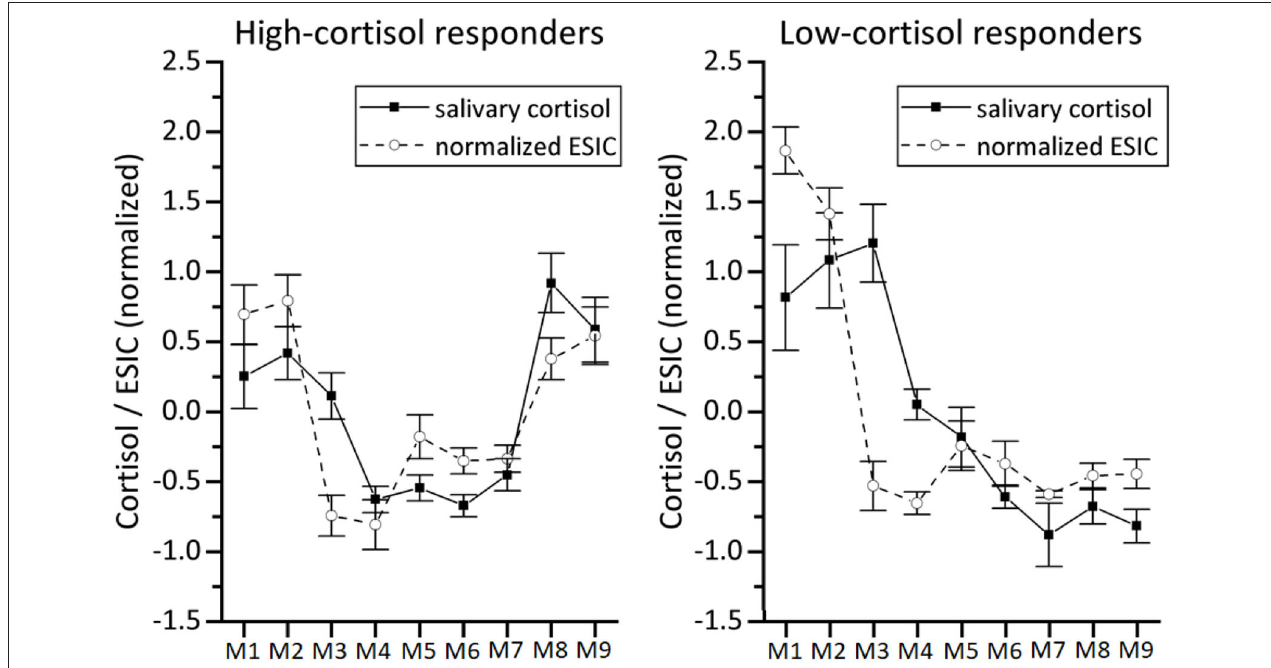
FIGURE 10 | Comparison between normalized salivary cortisol and our normalized stress-induced cortisol estimation (normalized ESIC) based on DTI-4 skin conductance data for the high-cortisol responders (left panel, n = 22) and low-cortisol responders (right panel, n = 6). Because of the z -score normalization, values at the vertical axis are distributed around 0. Error bars represent ± SE.